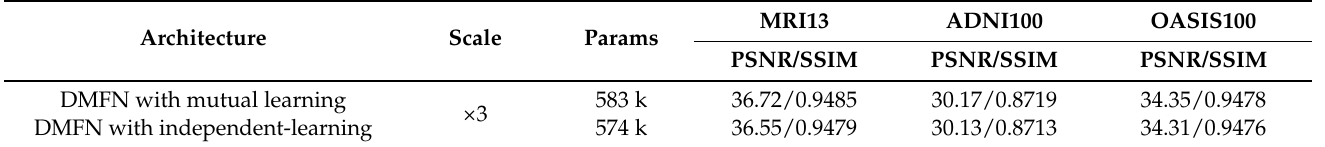
Figure 7. The comparison of our mutual-learning method and the independent-learning method between the two back-projection units. The black arrows show the mutual learning between two units, which are not used in independent-learning. Table 3. Comparisons of mutual learning and independent learning on